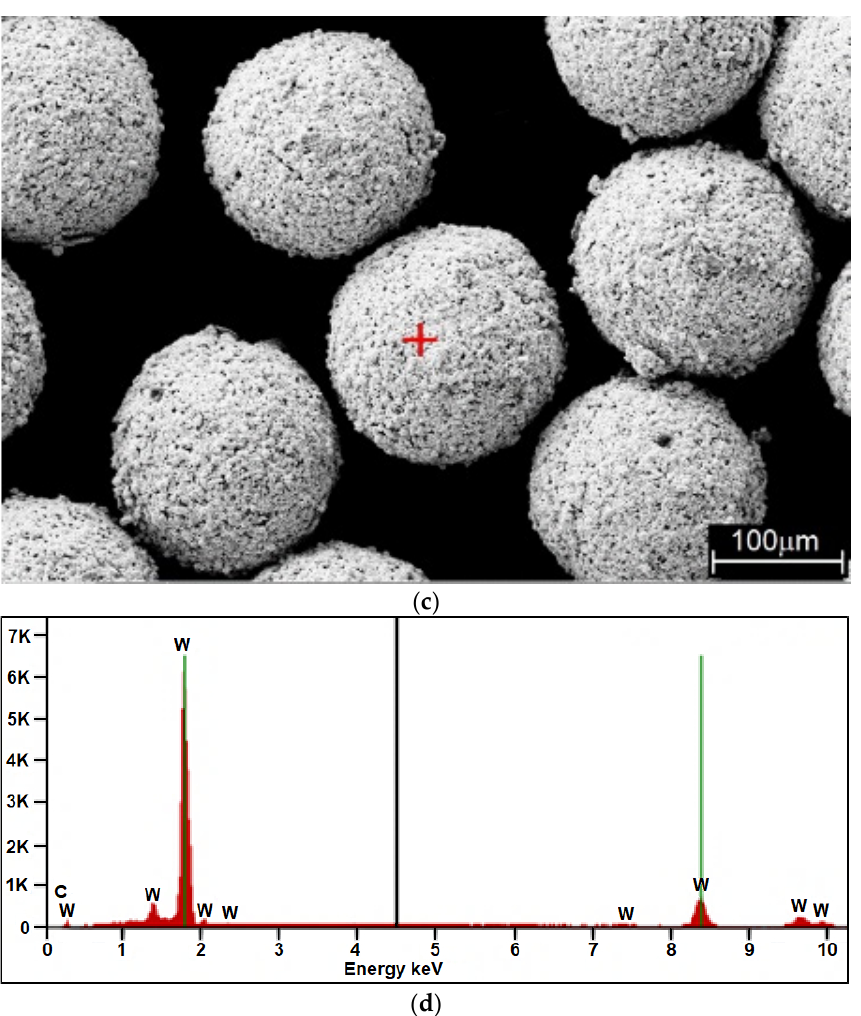
Figure 1. Components of the hard phase in the Co3+TiC+PD-W powder: ( a ) sharp-edged titanium carbide, TiC (mag. × 300); and ( c ) synthetic metal–diamond composite in the tungsten lagging, PD-W (mag. × 500), and diagram of the energy of scattered X-radiation with energy lines present in the area of components: (chemical elements (ceramic particle of TiC and metal matrix)) subjected to analysis ( b ) ceramic particle of TiC; ( d ) tungsten-coated synthetic metal–diamond composite (PD-W).